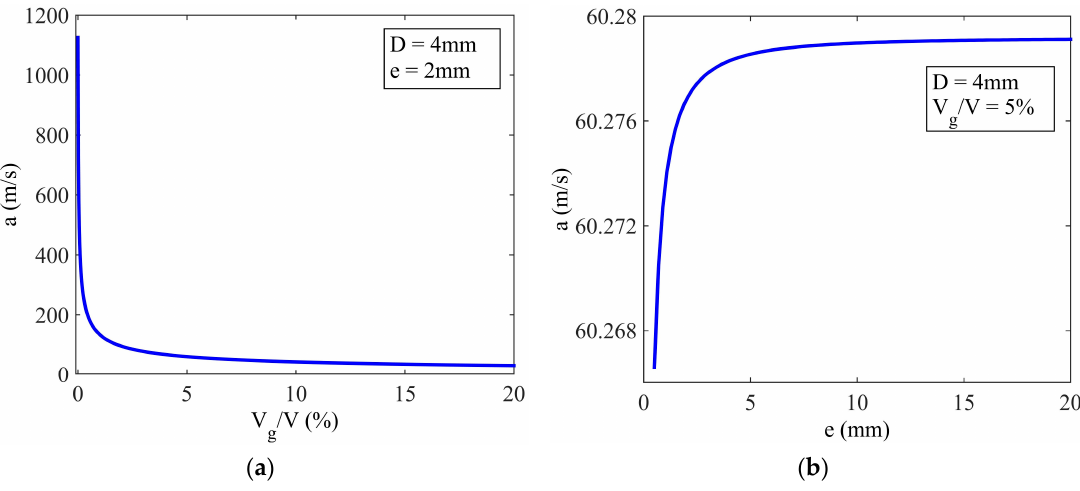
Figure 7. Wave speed in the circular tube. ( a ) The influence of the gas volume on the wave speed; ( b ) the influence of wall thickness on the wave speed. Table 2. Parameters in the simulation of wave speed model.